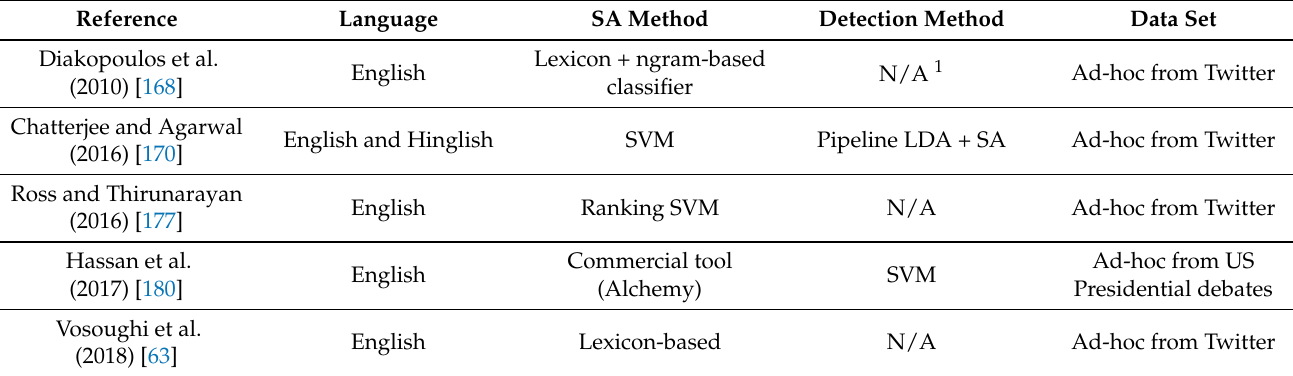
Table 1. Main characteristics of fake news detection systems using SA: systems that do not provide quantitative performance results on the